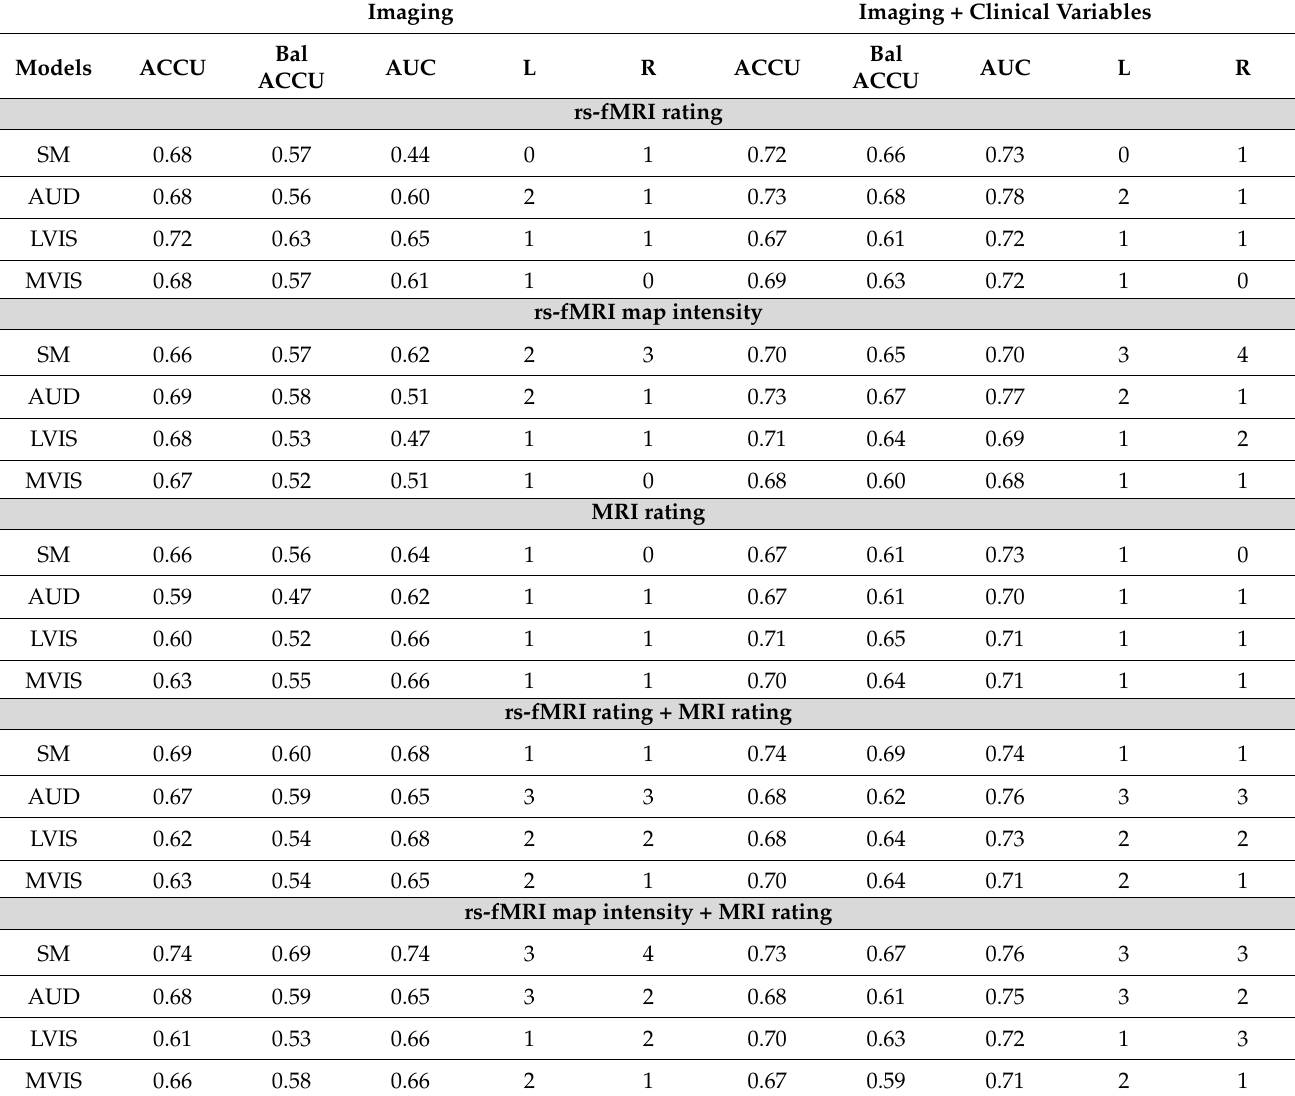
Table 2. Diagnostic accuracy of the five models (multivariate logistic regressions) for each single network, considering imaging and imaging + clinical